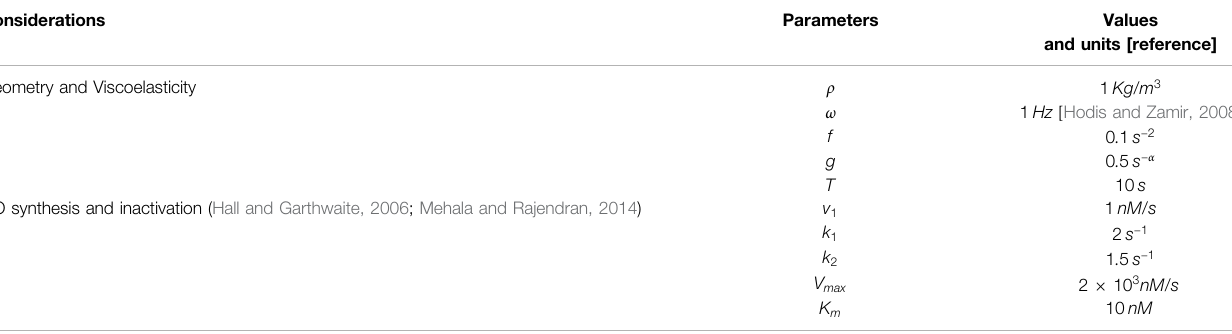
TABLE 1 | List of parameters with corresponding values and units. Due to a lack of experimental data, the value of T was fi xed fi rst, and then, the values of f and g were chosen such that a semi-analytic solution could be found for the initial boundary value problem Eqs 15 – 17 . The normalized value of the wall ’ s density was chosen for mathematical